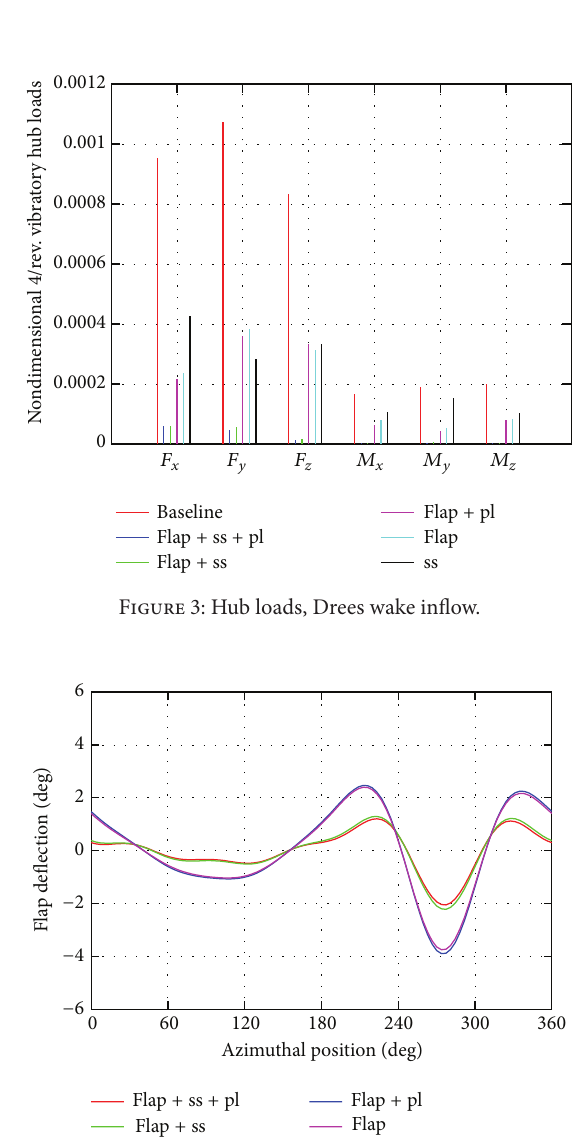
Figure 4: Flap deflections time